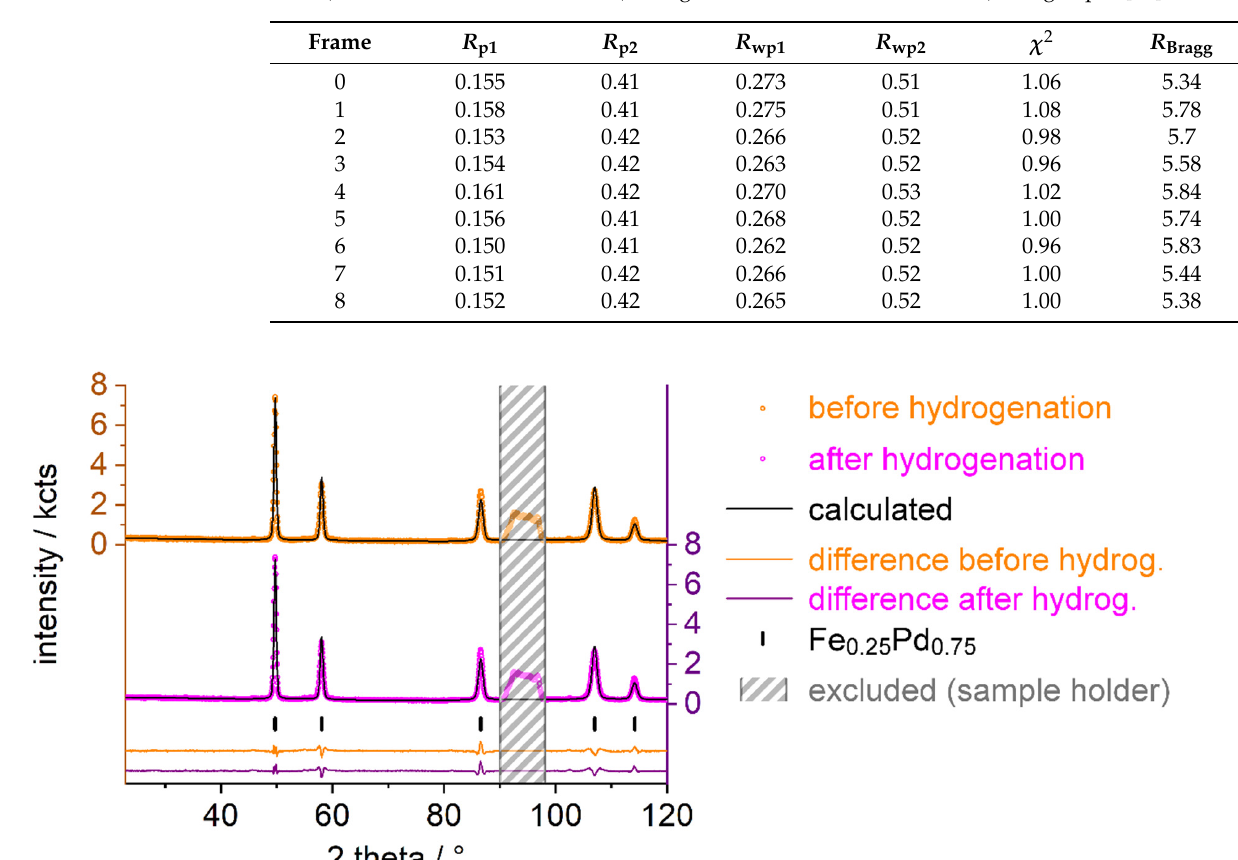
Table A4. Residual parameters of the Rietveld refinement of FePd 3 (long-time annealed sample, Pm 3 (cid:3364) m ) based on in situ XRPD data (see Figures A5 and A6, and Table A3) using Topas [25].